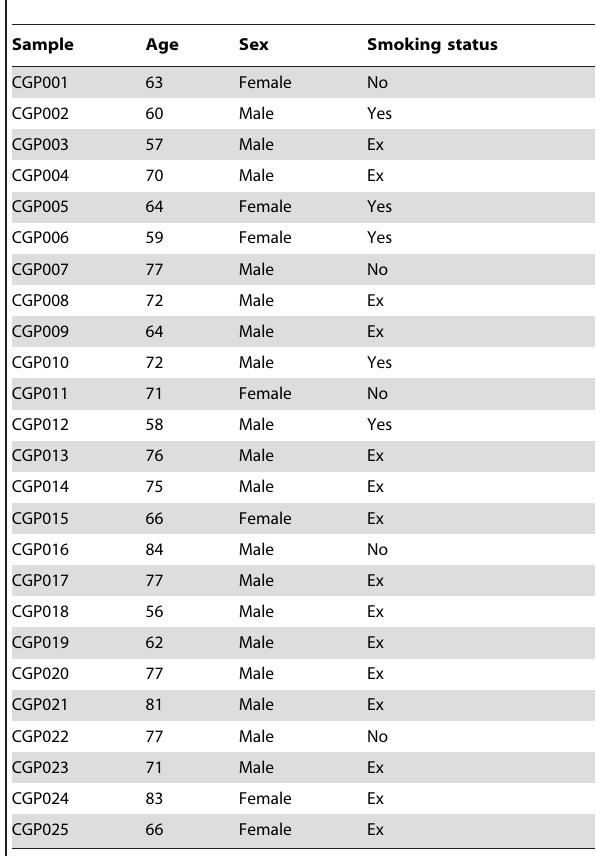
Table 3. Characteristics of controls from the general population